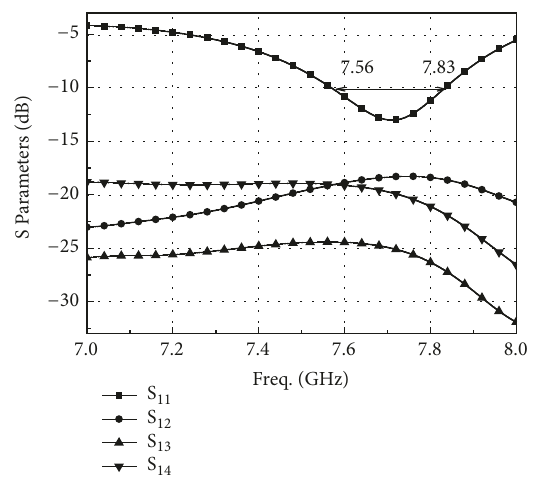
Figure 7: Return loss and inserting loss for the OAM generator (a= 14.8mm).